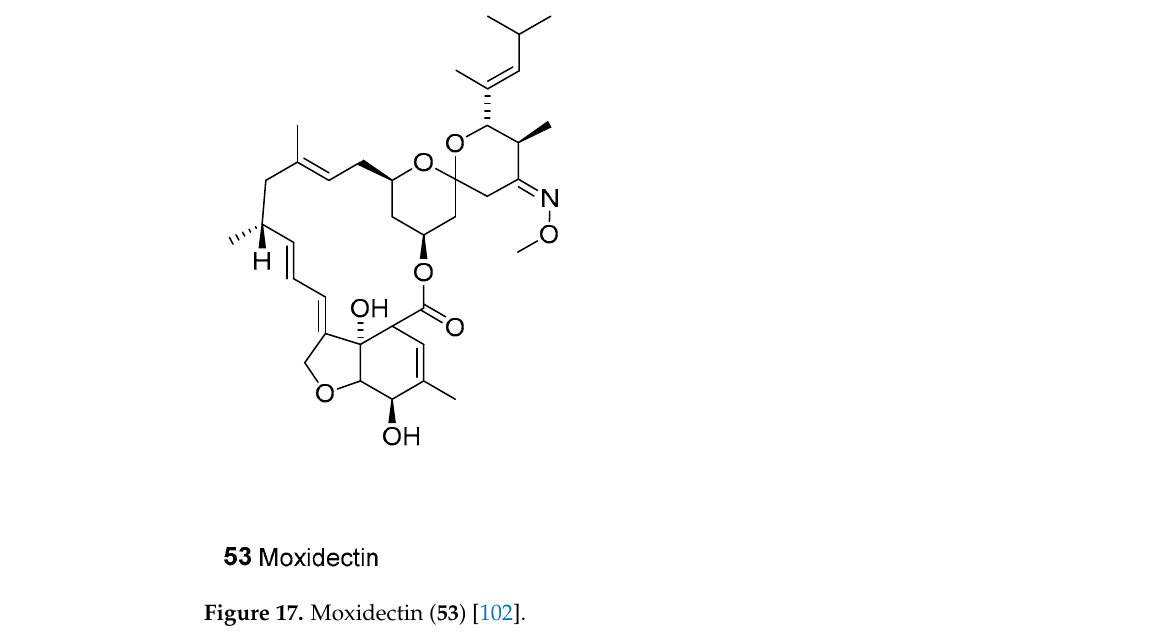
Figure 17. Moxidectin ( 53 )